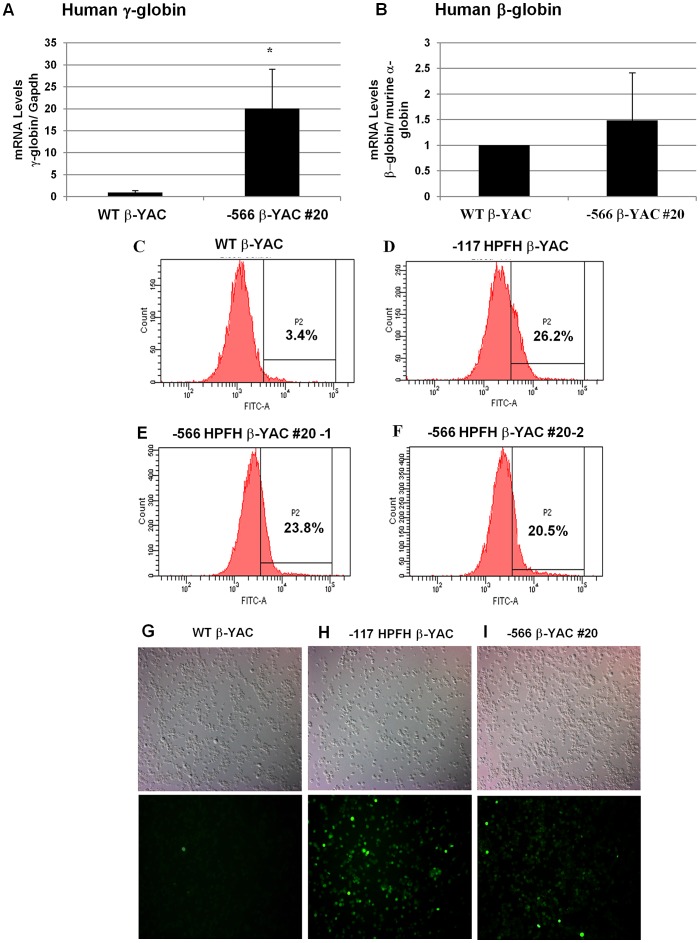
Human β-like globin expression in adult −566 Aγ-globin HPFH β-YAC transgenic mice.(A and B) Expression of the fetal γ- and adult β-globin was analyzed by real-time qRT-PCR and the data was normalized to mouse α-globin or Gapdh gene expression. (A) Human fetal γ-globin mRNA expression; B) Adult β-globin mRNA expression. Lines are indicated at the bottom of the plot. Results are the average of triplicate experiments from three animals of lines 20. * indicates P<0.05. (C–F) Flow cytometry analysis was performed using a mouse monoclonal anti-γ-globin antibody to determine the percentage of F cells. C) Wild-type β-YAC; D) −117 Greek HPFH β-YAC; E) −566 Aγ-globin HPFH β-YAC transgenic line 20 (1), F) −566 Aγ-globin HPFH β-YAC transgenic line 20 (2). Flow cytometry controls are identical to those shown in Figure 2A, 2B and 2G since the experiments were performed together. (G–I) Cytospins were prepared using an anti-human hemoglobin F FITC-conjugated antibody. G) Wild-type β-YAC; H) −117 Greek HPFH β-YAC; I) −566 Aγ-globin HPFH β-YAC transgenic line 20. Top panels, visible light images of cytospin cells; bottom panels, immunofluorescent images of same fields.